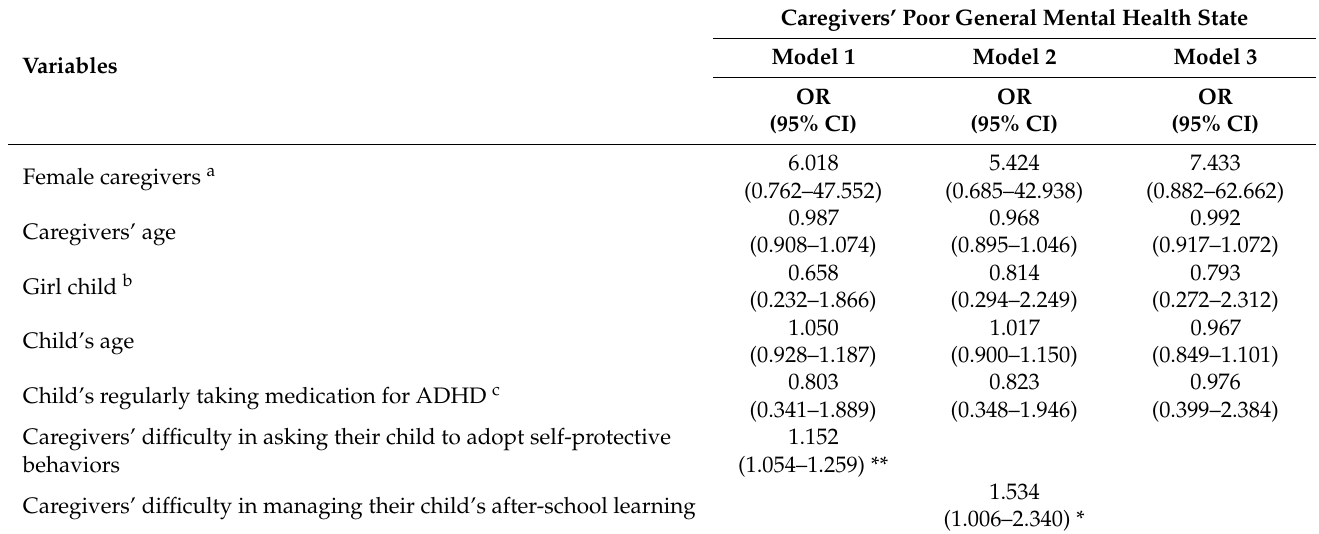
Table 4. Factors Related to Caregiver Mental Health: Multivariate Logistic Analysis .